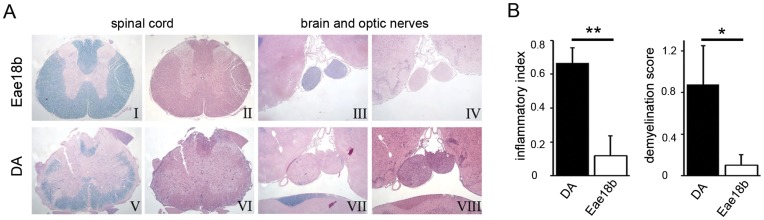
Congenic DA.PVG-Eae18b rats developed less severe neuroinflammation and demyelination.(A) Histopathological analysis of the group representative paraffin embedded tissue cross-sections from congenic and control spinal cord (I, II and V, VI, respectively) or brain and optic nerves (III, IV and VII, VIII, respectively) on day 15 p.i. (five congenic and four control animals analyzed). Sections were stained with Klüver (I, III, V, VII) to reveal demyelination and Hämalaun & eosin (II, IV, VI, VIII) to detect inflammatory infiltrates. The congenic strain showed minor subpial demyelination and cell infiltration in the spinal cord (I, II), while the brain and optic nerves remained intact (III, IV). In contrast, the control strain displayed confluent subpial demyelinated lesion of the spinal cord white matter (V, VI) as well as an extensive myelin loss in both optic nerves (VII) accompanied by recruitment of inflammatory cells (VIII). (B) Analysis of the material shown in A. Inflammatory index (I.I., first graph from left) and demyelination score (DM, second graph) are both significantly higher in DA controls compared to Eae18b congenic rats. Error bars represent SEM, and (*) indicates p-value <0.05, (**) indicates p-value <0.01 calculated by Students t-test.